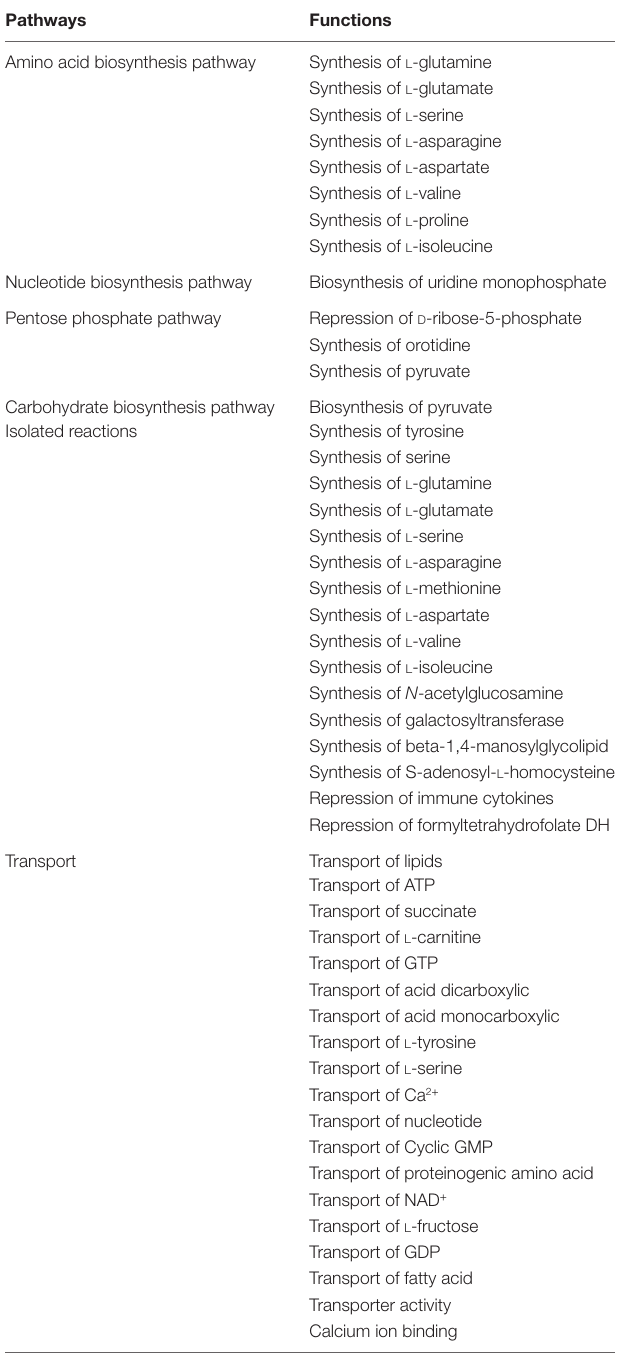
Table 8 | Metabolic pathways associated with fly